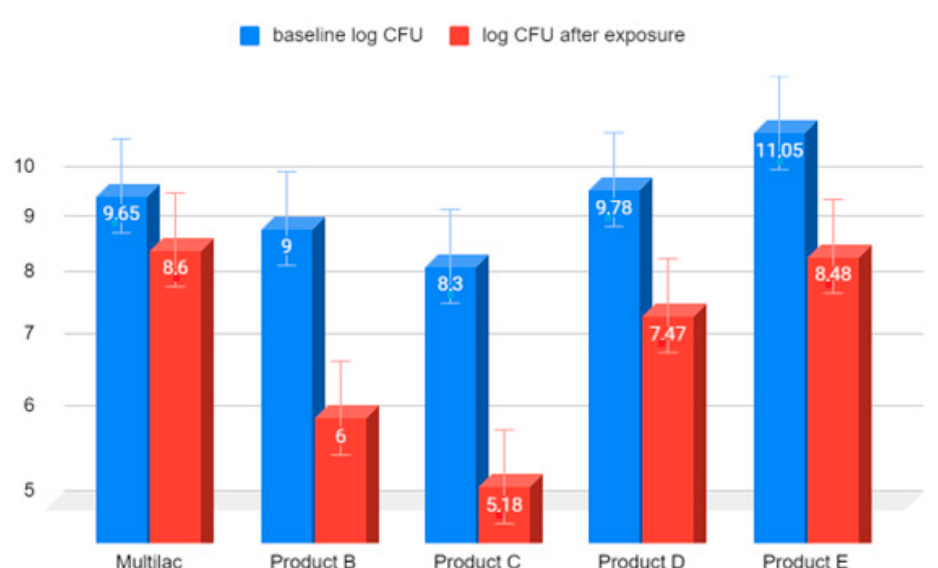
Figure 3. Comparison on a logarithmic scale of the decrease in the number of live LAB bacteria in market preparations of probiotics after 90 min of exposure to HCl solution at pH 2. Arithmetic means of three independent experiments.